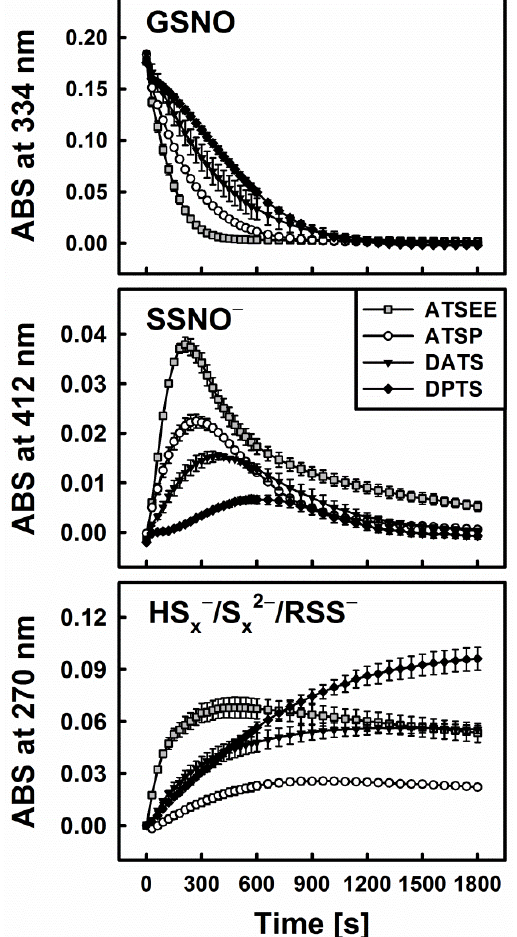
Figure 6. Kinetic traces of the interactions of 200 µM of synthetic trisulfanes ATSP and ATSEE, respectively, with 200 µM GSNO in the presence of 800 µM Cys. The traces for DATS and DPTS are shown for comparison.